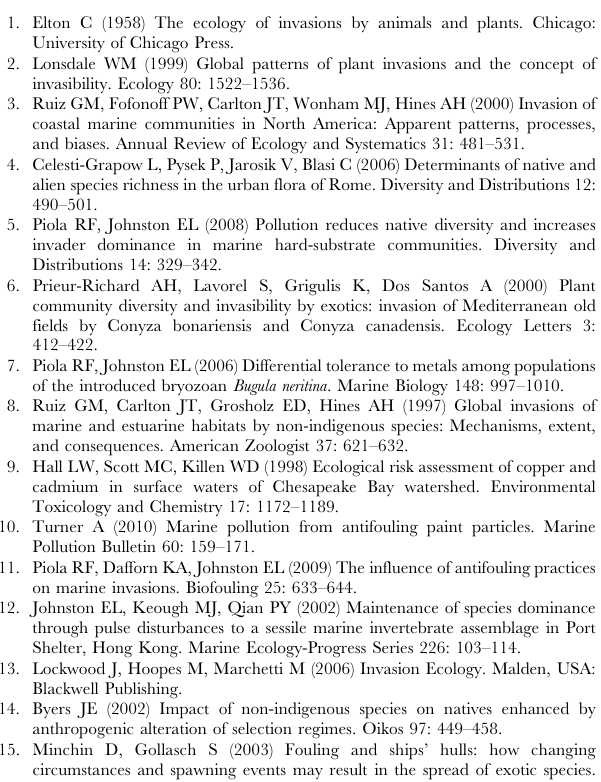
Figure S1 Individual replicates from fouling communi- ties in Virginia across disturbance treatments. Panel A –